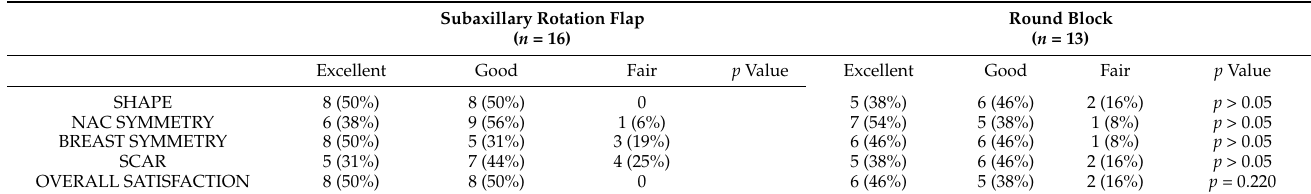
Table 5. Aesthetic results—patient’s assessment.